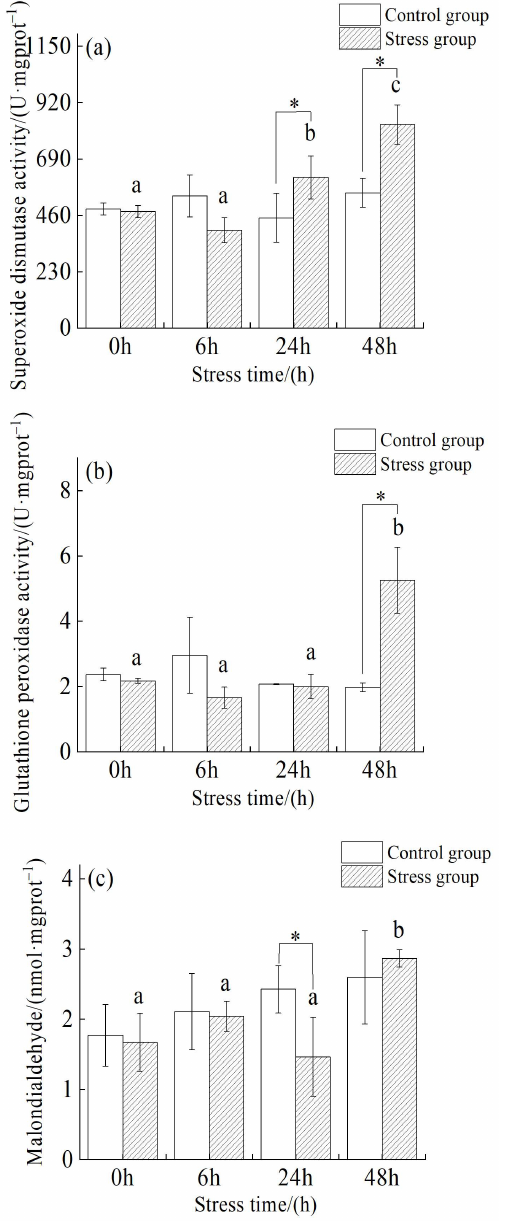
Figure 2. Effect of acute low salt stress on the antioxidation of gills of juvenile yellowfin fish ( Thunnus albacares) , ( n = 9). ( a ), Superoxide dismutase activity; ( b ), Glutathione peroxidase activity; ( c ), Malondialdehyde. Different letters indicate that there is a significant difference in the same salinity group at different time points ( p < 0.05). Different letters indicate the difference between the experimental group and the control group over time, and * indicates the difference between the experimental group and the control group.